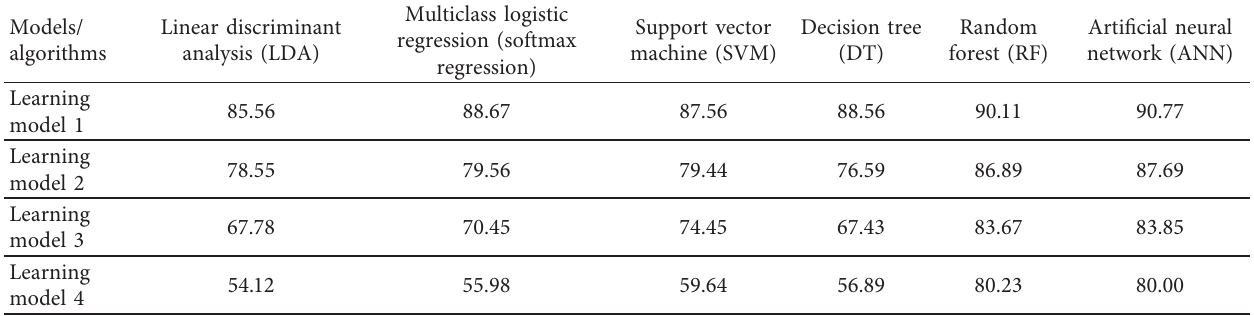
Table 4: Accuracy results of machine learning algorithms and ANN on five-level grades’ classification.